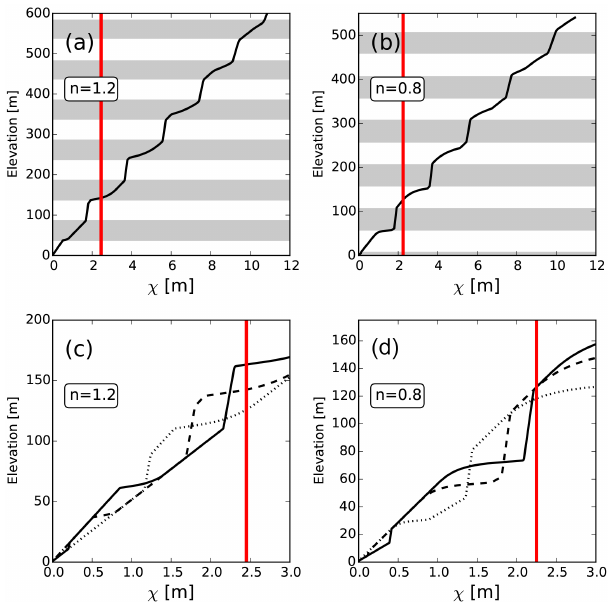
Figure 9. Simulations of knickpoint propagation and damping from base level. Entire equilibrium profiles are depicted for cases where n = 1 . 2 (a) and n = 0 . 8 (b) . Panels (c) and (d) show zoomed-in figures that depict three separate time steps (dotted, dashed, and then solid) as fast knickpoints catch up with slow knickpoints at the calculated damping length scale ( λ , thick red line). The interaction of the two knickpoints can be visualized as the reduction in size of a slope patches that are at the topographic equilibrium slope as these patches approach λ